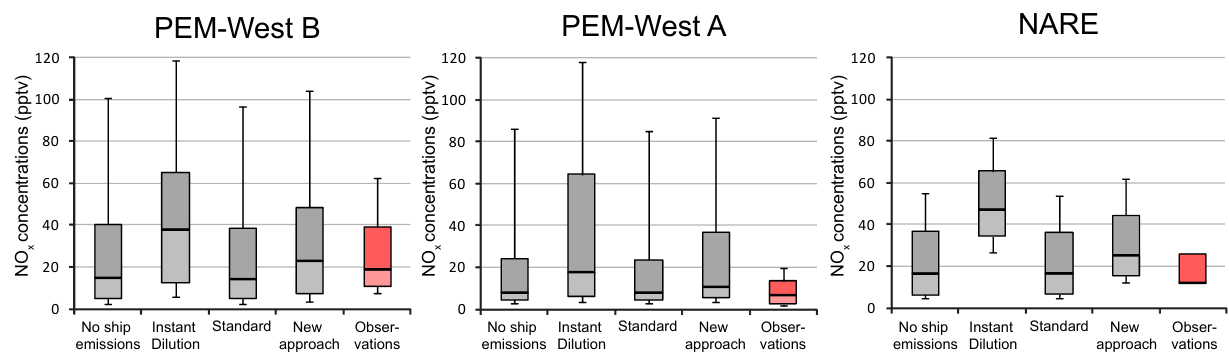
Fig. 4. Box & Whisker plot of simulated and observed median NO x concentrations (inpptv) for the PEM-West B campaign (left), the PEM-West A campaign (middle) and the NARE campaign (right), averaged over the lower 1.2km. Each box shows the data between the upper and lower quartiles (25th and 75th percentile), with the median represented by a horizontal line; whiskers go out to the 5th and 95th percentile of the data. PEM-West B measurements were taken from 7 February till 14 March 1994, PEM-West A measurements were taken from 16 September till 21 October 1991, and NARE measurements were taken during September 1994. Simulations were performed for the year 2005. The PEM-West A and PEM-West B data was obtained from the Atmospheric Chemistry Division, National Center for Atmospheric Research, University Corporation for Atmospheric Research (available at http://cdp.ucar.edu/). For the NARE campaign we use statistics reported in Kasibhatla et al. (2000). We converted all NO measurements into NO x concentrations using the NO from GEOS-Chem simulations.